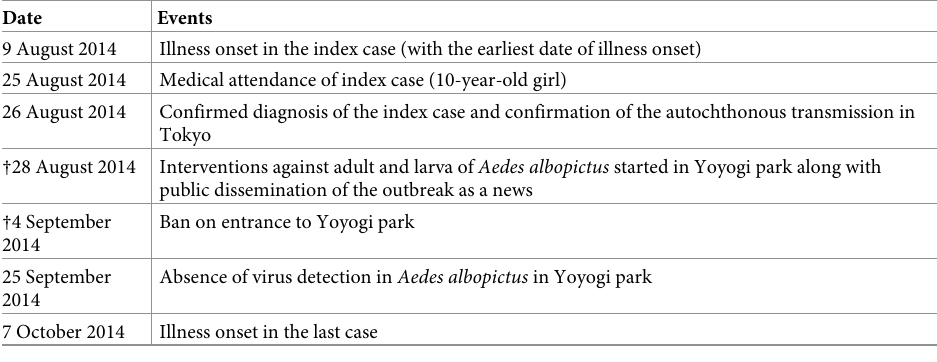
Table 1. Event log of the 2014 dengue outbreak in Tokyo,